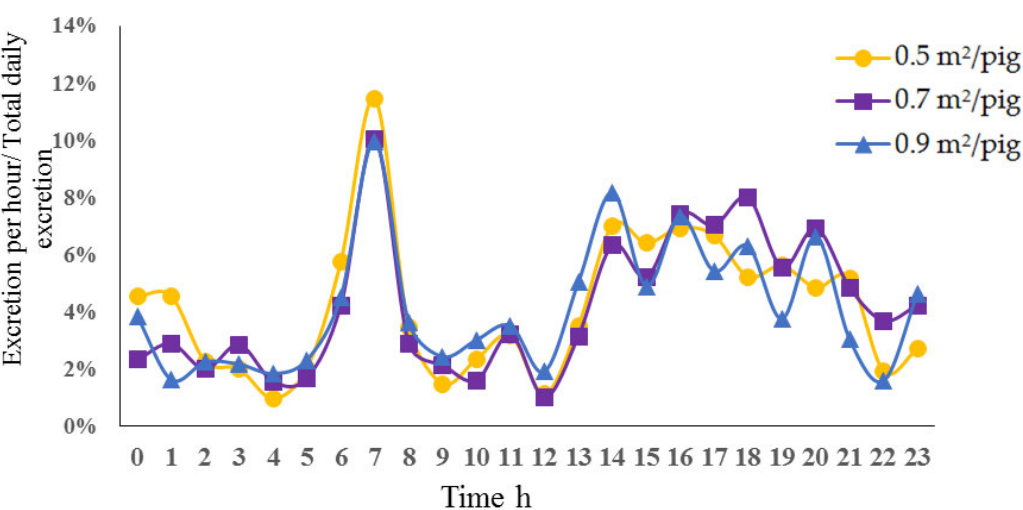
Figure 2. Daily variation in pigs’ excretion.